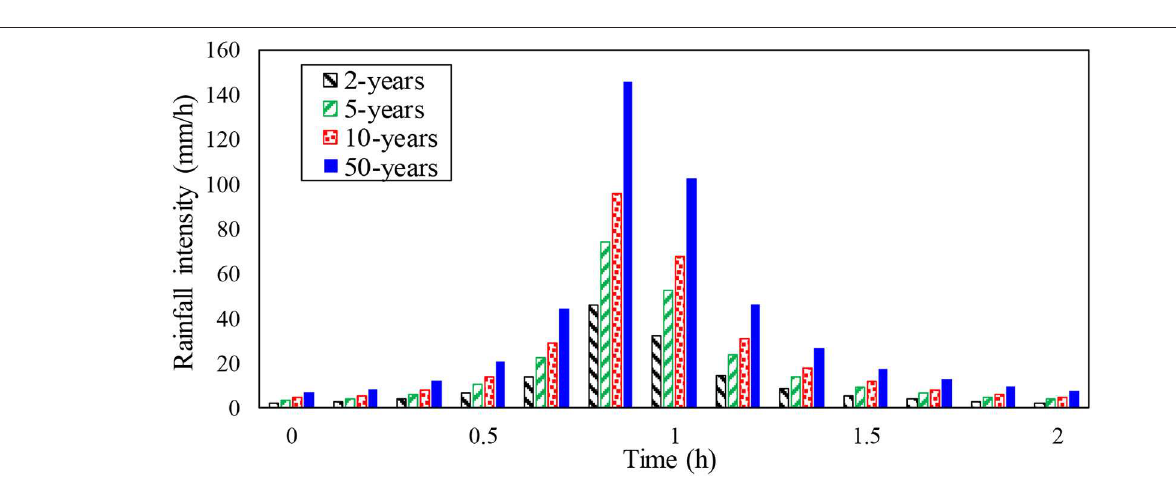
FIGURE 7 | Hyetography of design storms with different return